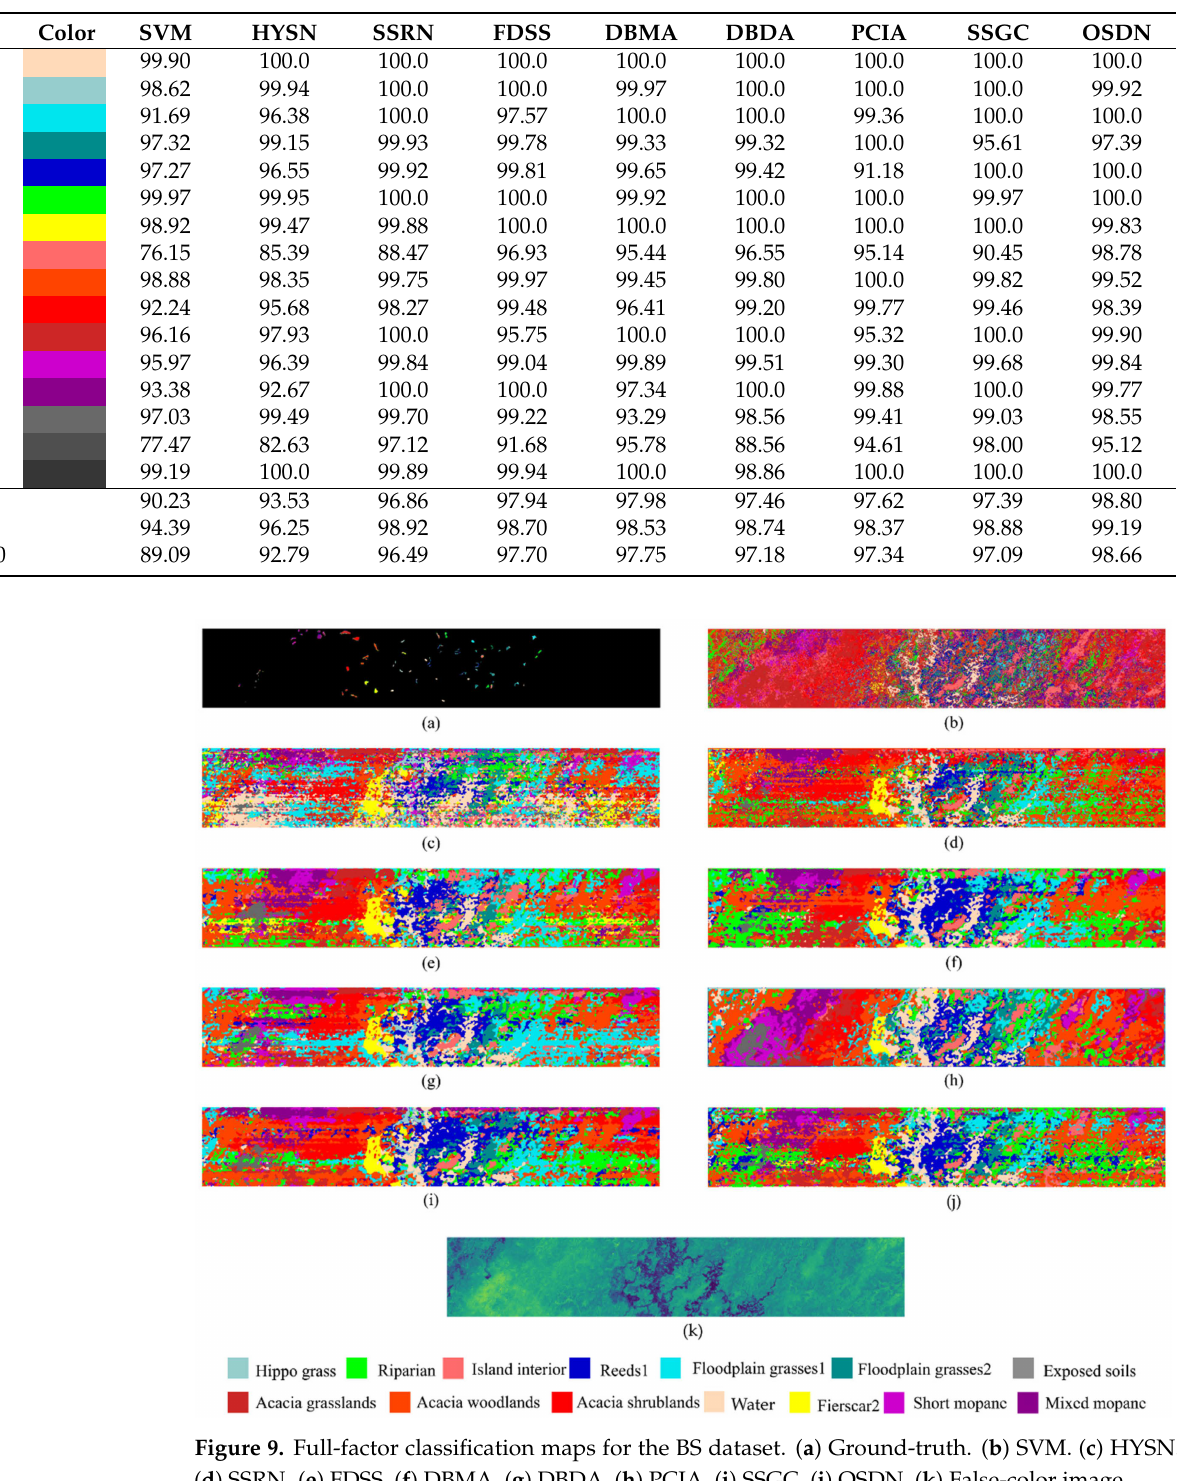
Table 15. Classification results of the SA dataset based on 2% training samples.